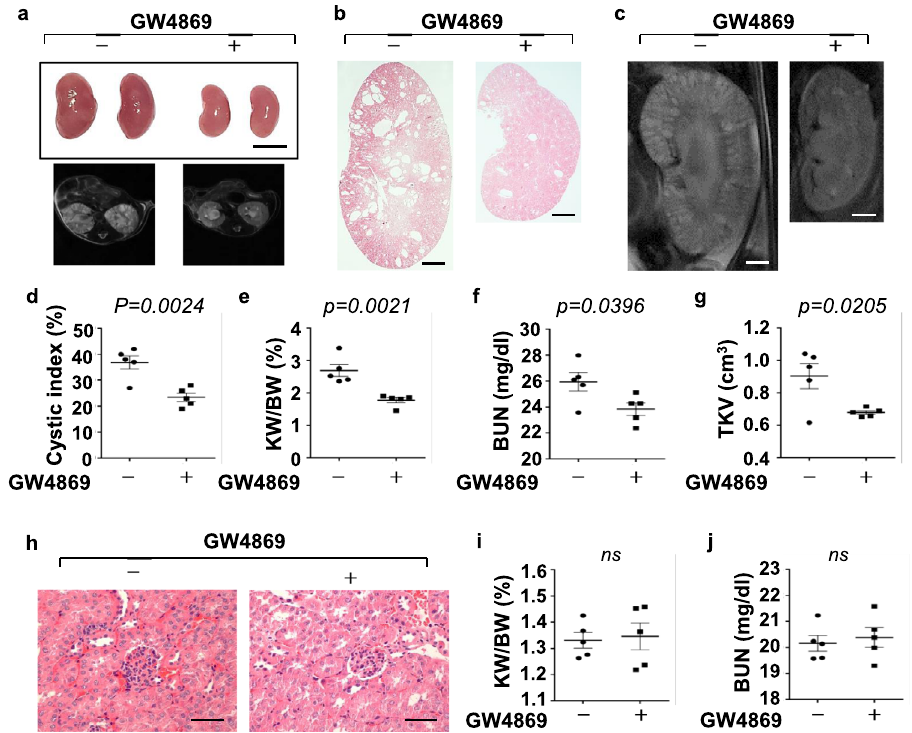
Fig. 8 Inhibition of exosome secretion with inhibitor, GW4869, delayed cyst growth in Pkd1 RC/RC mice. a Images of kidneys (top panel) and axial MRI images (bottom panel) from Pkd1 RC/RC mice treated with or without GW4869. Scale bars, 5 mm. b Histological examination of kidneys from Pkd1 RC/RC mice treated with or without GW4869. Scale bars, 1 mm. c MRI images from Pkd1 RC/RC mice treated with or without GW4869. Scale bars, 1 mm. d Treatment with GW4869 deceased cystic index in kidneys from Pkd1 RC/RC mice ( n = 5) compared to that in kidneys from control mice treated with DMSO ( n = 5). Treatment with GW4869 decreased KW/BW ratios ( e ) and BUN levels ( f ) in Pkd1 RC/RC mice compared to those in kidneys from control mice treated with DMSO. g Total kidney volume (TKV) was calculated by MRI scan in each group. h Histological examination of kidneys from wild-type mice treated with GW4869 ( n = 5). Scale bars, 1 mm. Treatment with GW4869 did not affect KW/BW ratios ( i ) and BUN levels ( j ) in GW4869-treated wild-type mice compared to the controls. All statistical data are represented as mean ± SEM, and p values are calculated by unpaired Student ’ s t